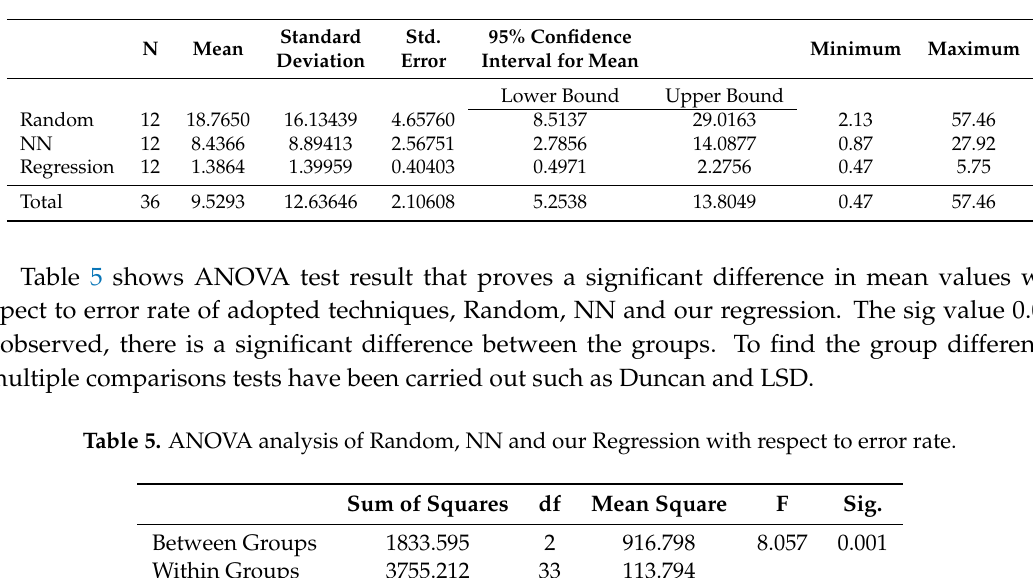
Figure 12. Performance of different initialization techniques with respect to Error Rate (%) for four classes of TSP instances. ( a ) Class 1; ( b ) Class 2; ( c ) Class 3; ( d ) Class 4. Table 4. Descriptive analysis of random, NN and our Regression technique with respect to error rate.